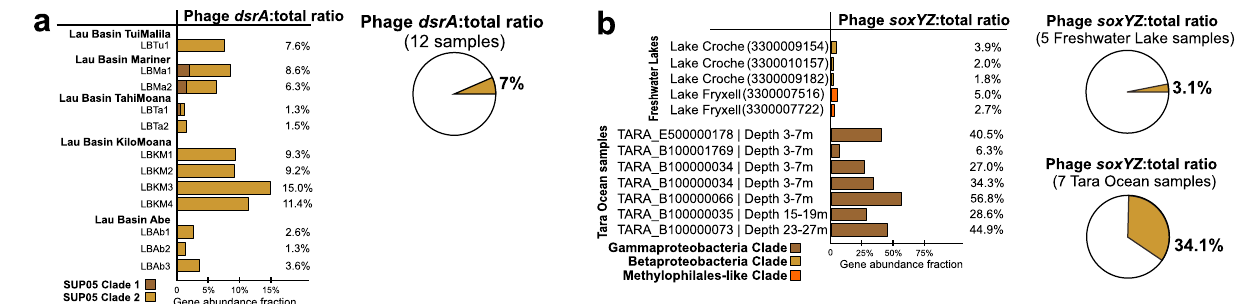
Fig. 6 Phage to total dsrA and soxYZ gene coverage ratios. a Phage dsrA to total (phage and bacterial dsrA gene together) gene coverage ratios. The contribution of phage dsrA genes from different SUP05 Gammaproteobacteria clades is shown in different colors. The average phage dsrA :total ratio was calculated from 12 samples. b Phage soxYZ to total gene coverage ratios. The contribution of phage soxYZ genes from three different clades is shown in different colors. Genes from freshwater lake and Tara Ocean samples were compared separately, and the average phage soxYZ :total ratios were calculated and compared separately as for freshwater lake and Tara Ocean samples. Tara Ocean sample IDs were labeled and the corresponding metagenome IDs